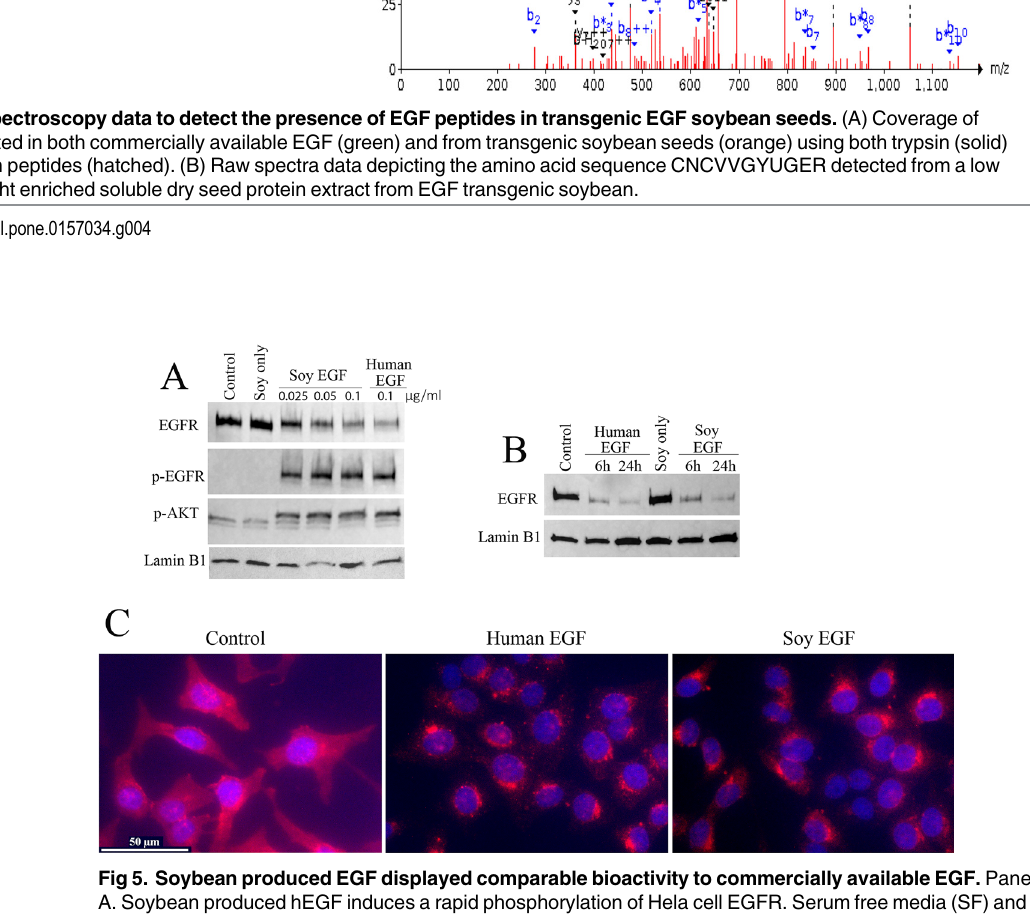
PLOS ONE | DOI:10.1371/journal.pone.0157034 June 17,